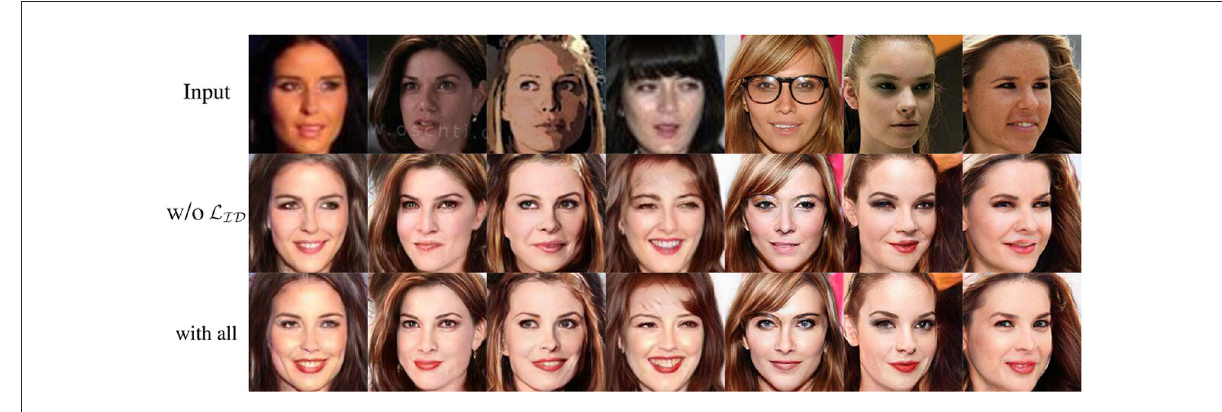
FIGURE7 Comparisons with and without ID Loss L ID . Note that the inclusion of ID loss can better preserve the identity information of a given face.